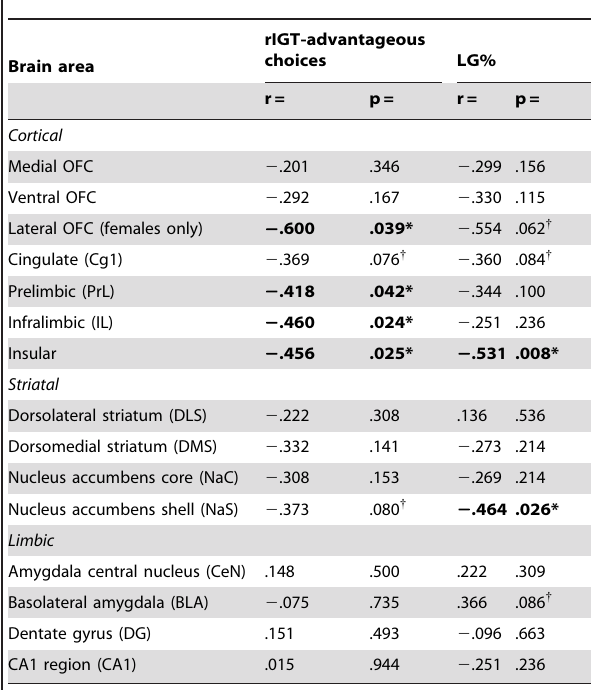
Table 1. Correlations of c-fos expression with rIGT performance and individual